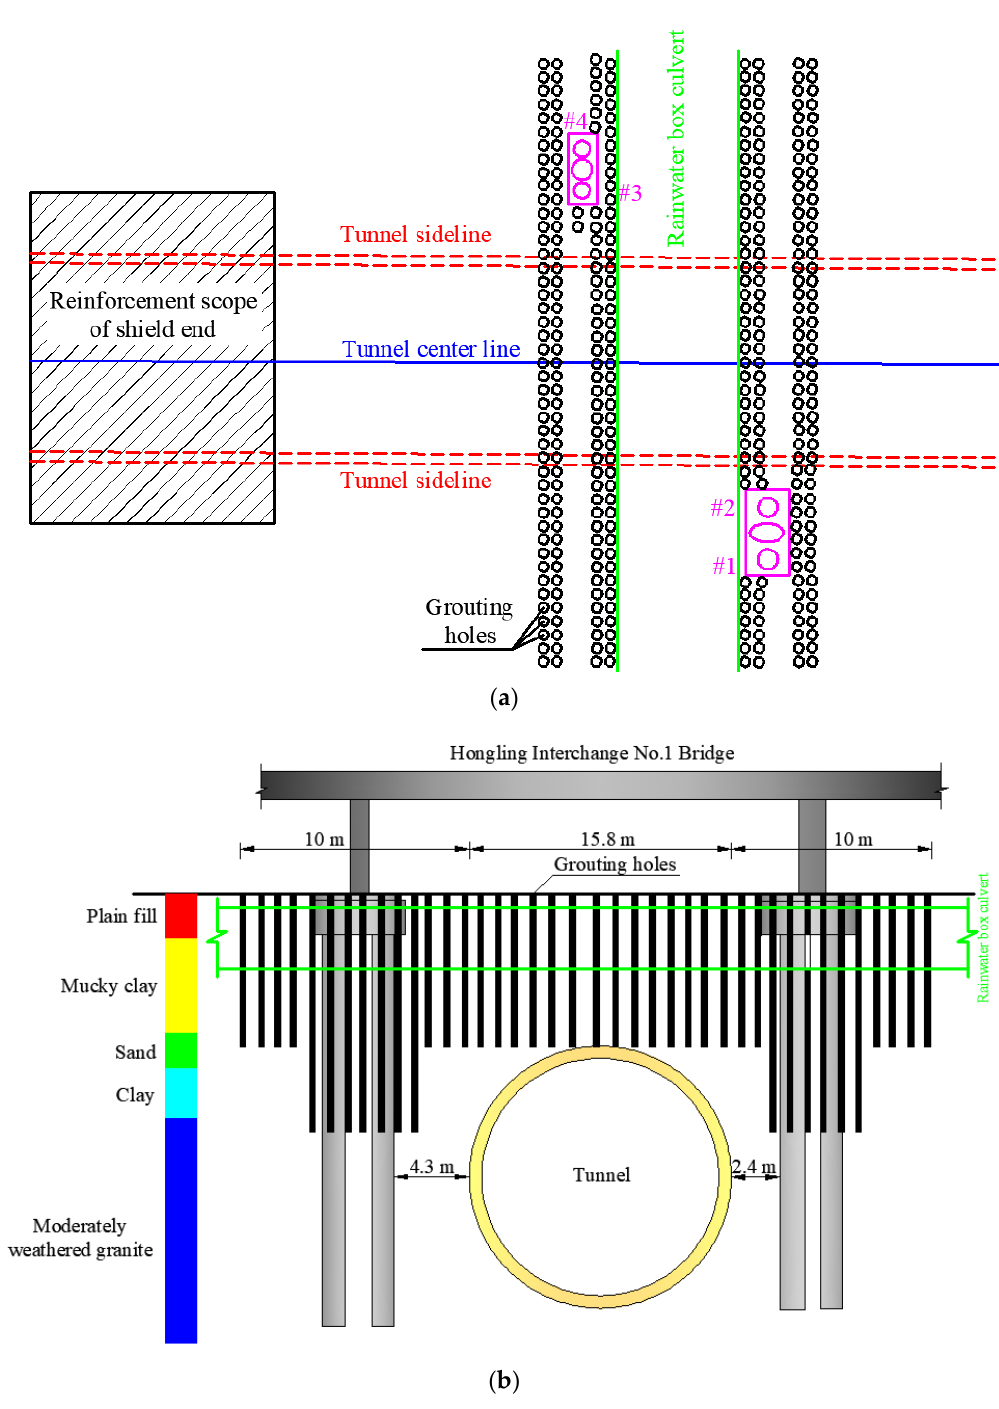
Figure 6. Grouting reinforcement scheme. ( a ) Plan of the grouting reinforcement scheme. ( b ) Section of the grouting reinforcement scheme.